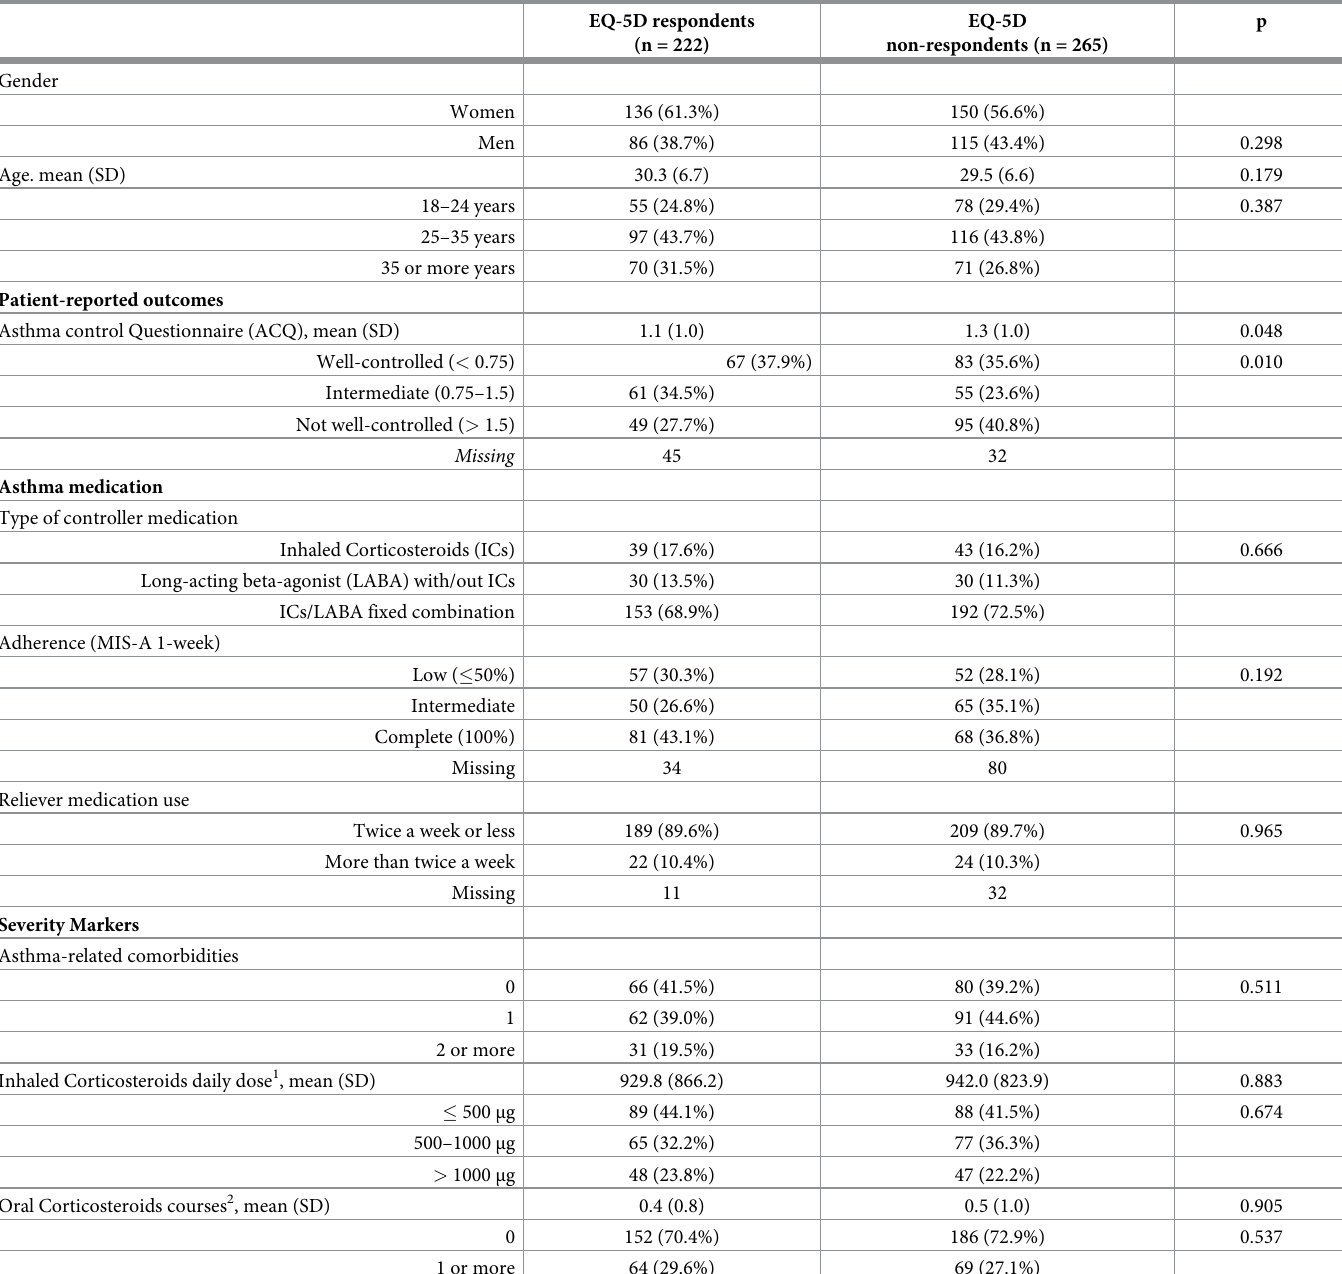
Table 4. Characteristics in respondents and non-respondents to the